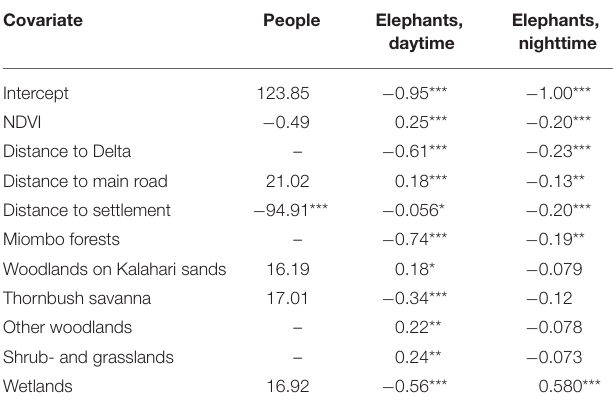
TABLE 2 | Resource selection functions were modeled using generalized linear models.